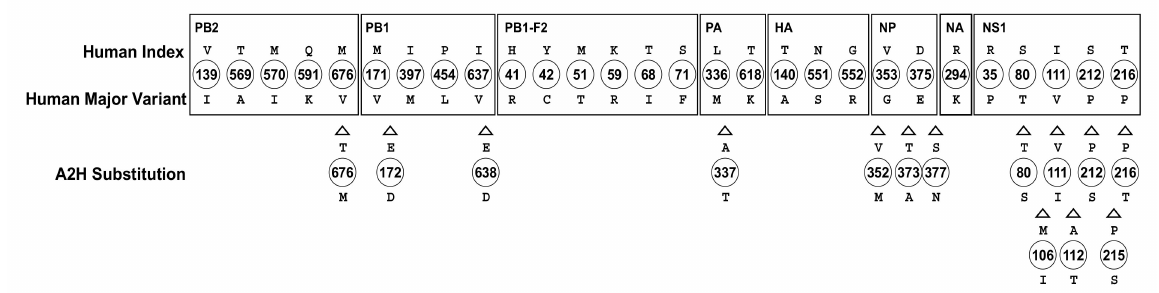
Figure 4. Major variant amino acid substitutions specific to human influenza A (H7N9) virus (H2H). The amino acid positions of the substitutions are indicated in the circles. Each site represents a major variant substitution, with an incidence of 10% or more, to the human virus index sequence. Some of the substitution sites are at close proximity (8 amino acids) or share the same amino acid position as the indicated avian-to-human (A2H) substitutions. Refer to Supplementary Table S3A–D for all A2H sites and Supplementary Table S5 for all H2H